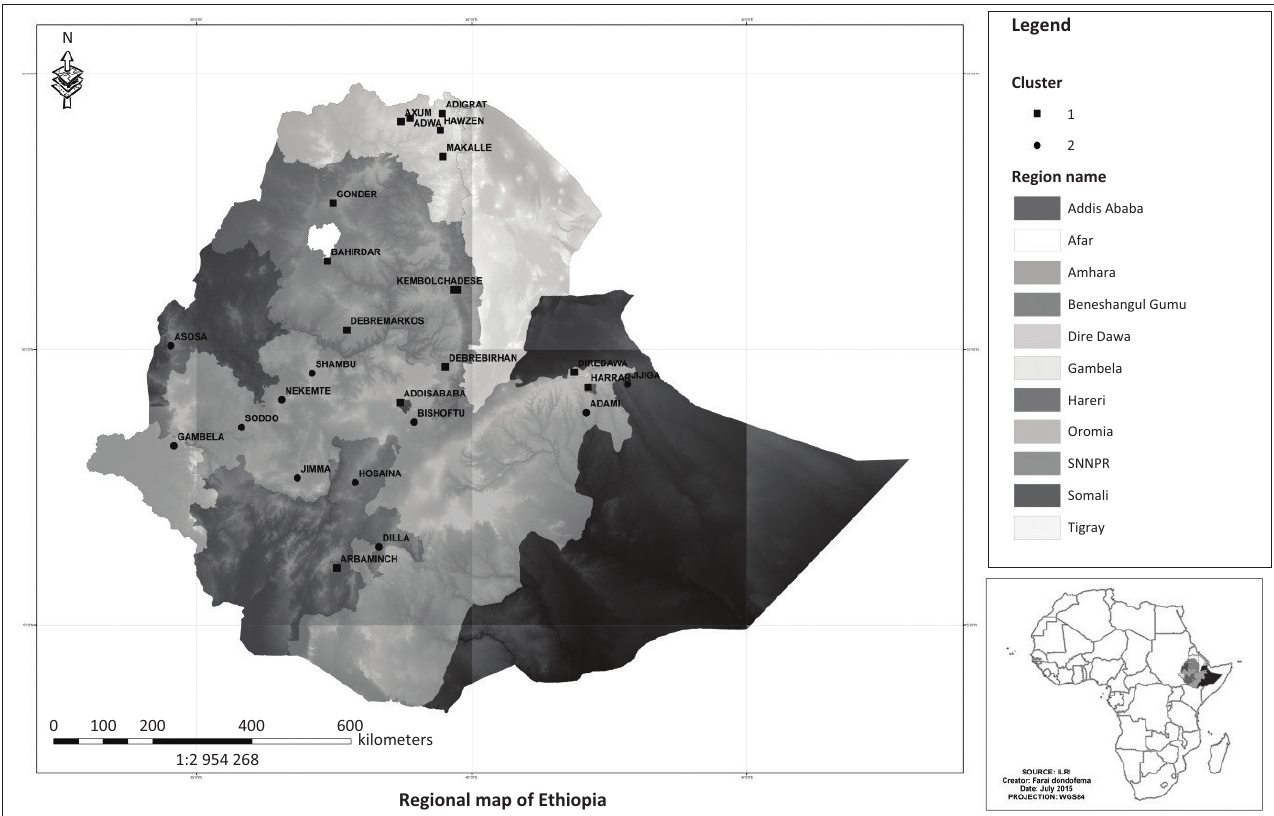
FIGURE 7: Spatial distribution of cities according to